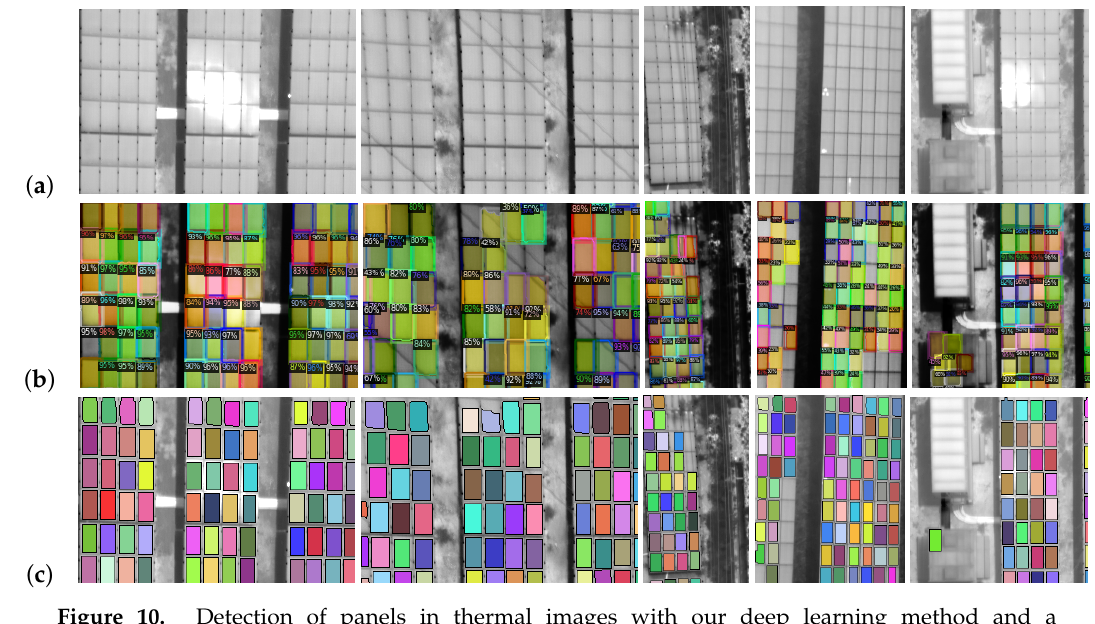
Figure 10. Detection of panels in thermal images with our deep learning method and a post-processing step. Different cases of true positives, false positives and false negatives: ( a ) thermal image in gray scale, ( b ) panel detection with deep learning, ( c ) after